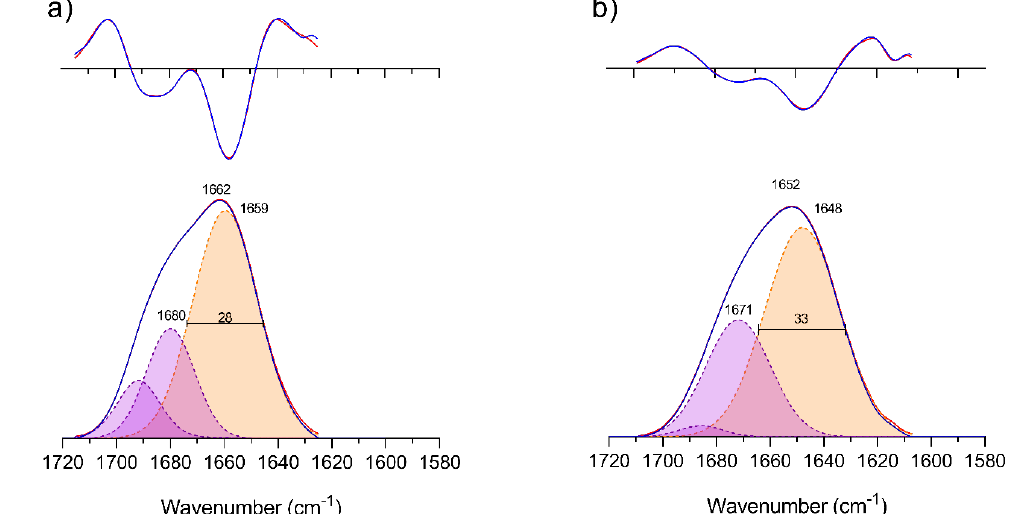
Figure 4. Band fitting of the amide I and its second derivative of SF dissolved in ( a ) EmimAc and ( b ) EmimAc and D 2 O after subtraction of the absorbance of the solvents. Top: second derivative of absorbance; bottom: ATR absorbance spectrum. Blue: Experimental spectrum and experimental second derivative; Red: fitted spectrum and fitted second derivative. The maximum ATR absorbance was 0.055 at 1662 cm −1 for panel ( a ) and 0.037 at 1652 cm −1 for panel ( b ).